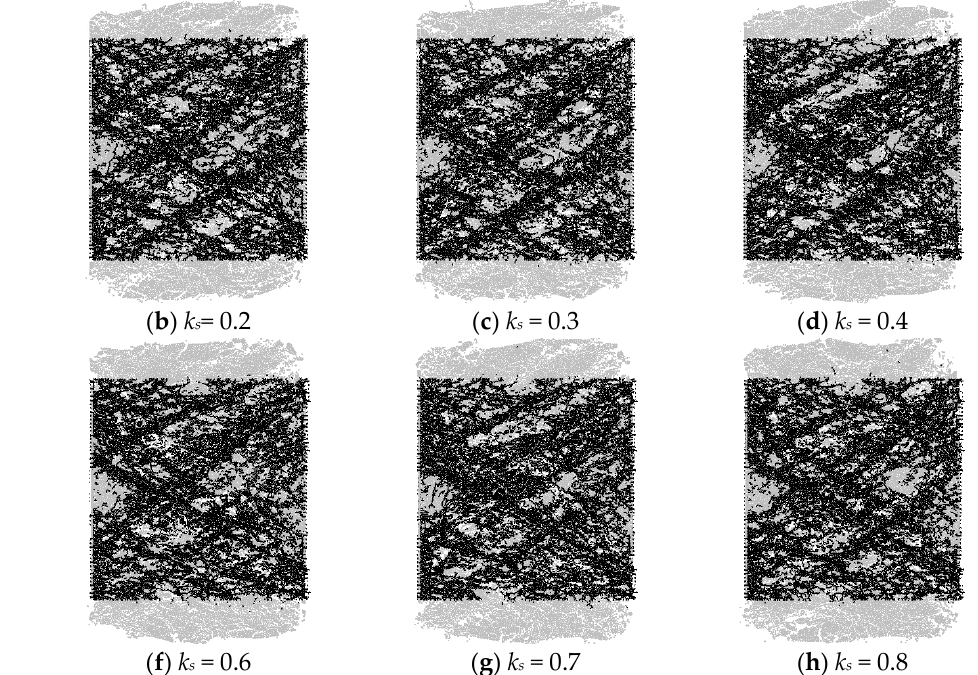
Figure 11. Failure mode of sample subject to different pre-stress levels at 14 m/s impact speed.